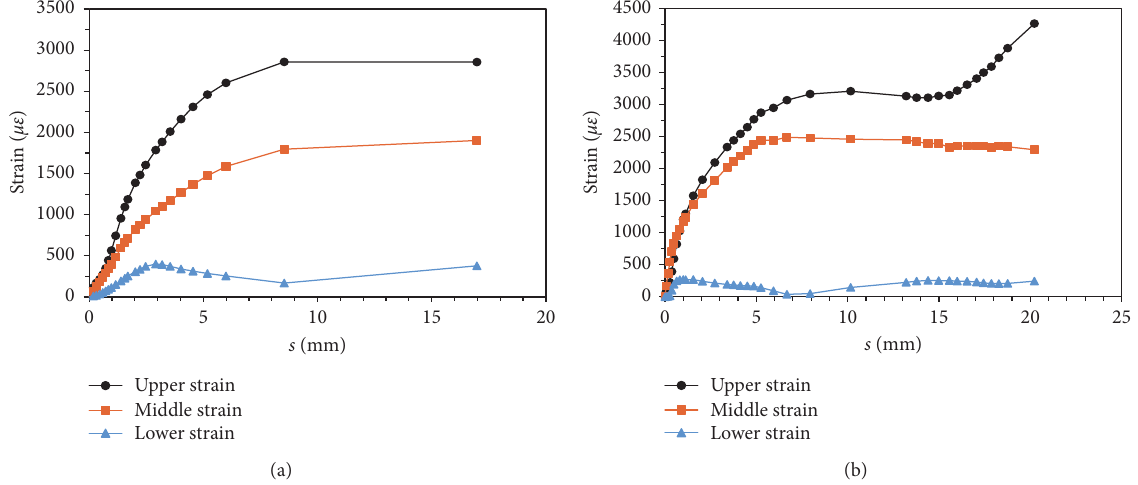
Figure 15: Strain-slip curves of specimens with shear connectors. (a) 4-3. (b)